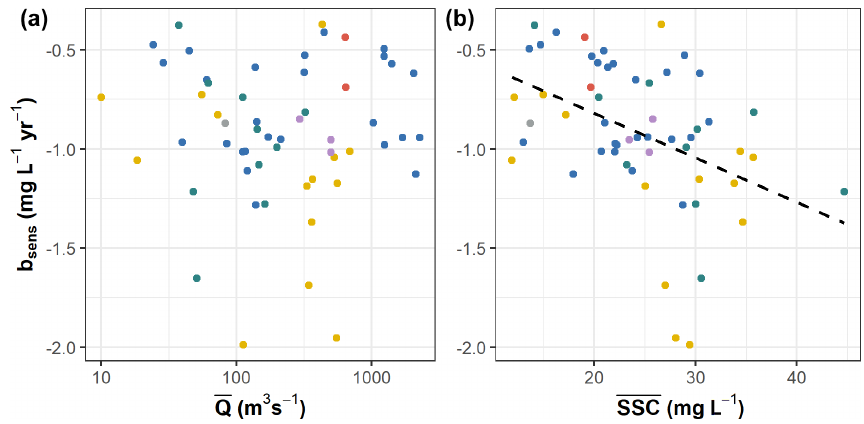
Figure 5. Sen’s slope for SSC of all stations as a function of mean discharge (a) and mean SSC (b) . Mean values refer to the period be- tween 1990 and 2010. Colors represent river systems (for legend see Fig. 2). The dashed line in (b) shows the linear regression between SSC and b Sens , with p ∼ 0 . 007 and R 2 = 0 . 18.